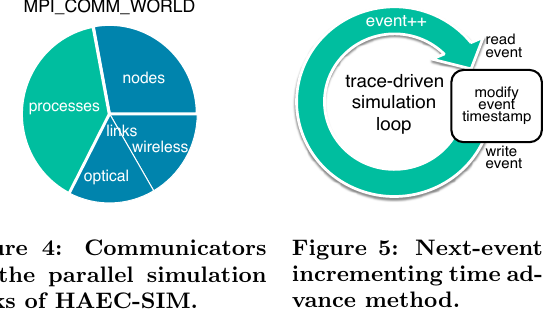
Figure 4: Communicators for the parallel simulation ranks of HAEC-SIM.